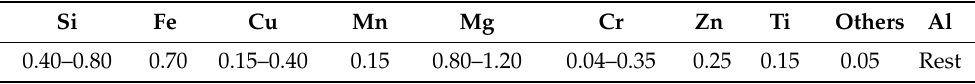
Figure 1. Experimental setup. Table 1. Composition (%) of